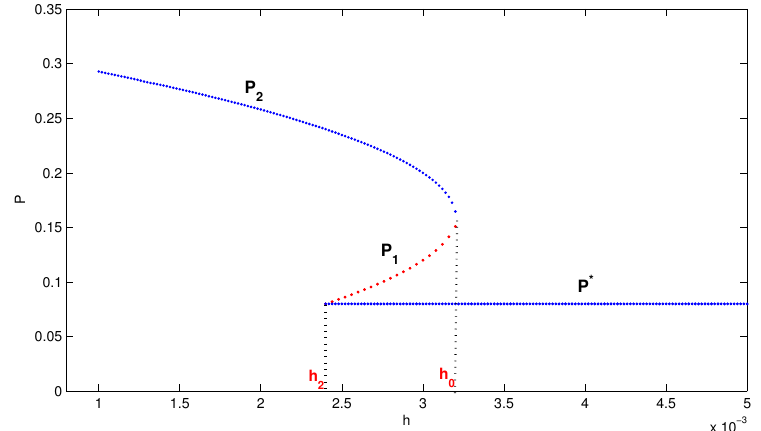
Figure 3. The bifurcation diagram with P 1 , P 2 and P ∗ versus h . The lines with P 1 and P 2 indicate the curves of the predator with coexistent equilibria E 1 and E 2 , respectively, and the line with P ∗ indicates the curve of the predator with coexistent equilibrium E ∗